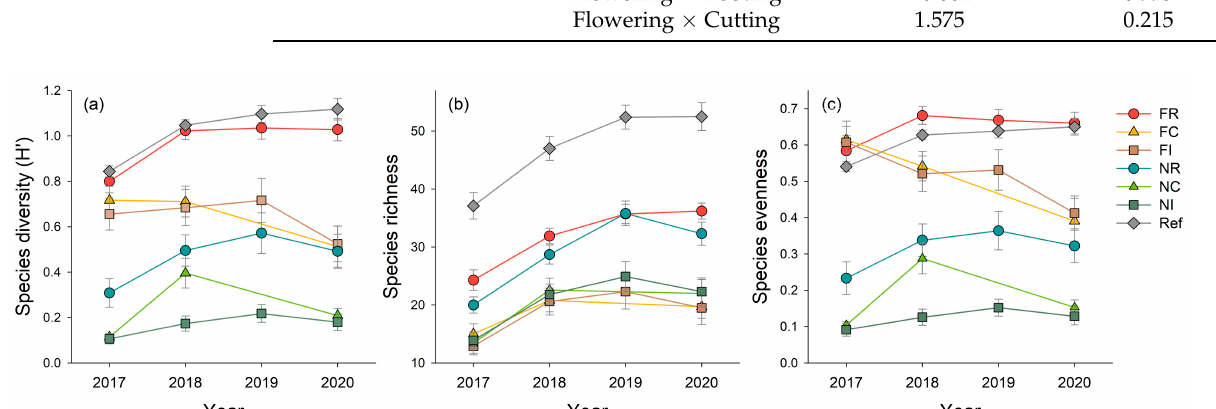
Figure 3. Stand-based species diversity indices in the stands with seven understory types over time. ( a ) Species diversity, ( b ) species richness, and ( c ) specie evenness. FR: flowering and rooting, FC: flowering and cutting, FI: flowering and intactness, NR: non-flowering and Rooting, NC: non-flowering and cutting, NI: non-flowering and intactness, Ref: reference. Values are average ± standard error.